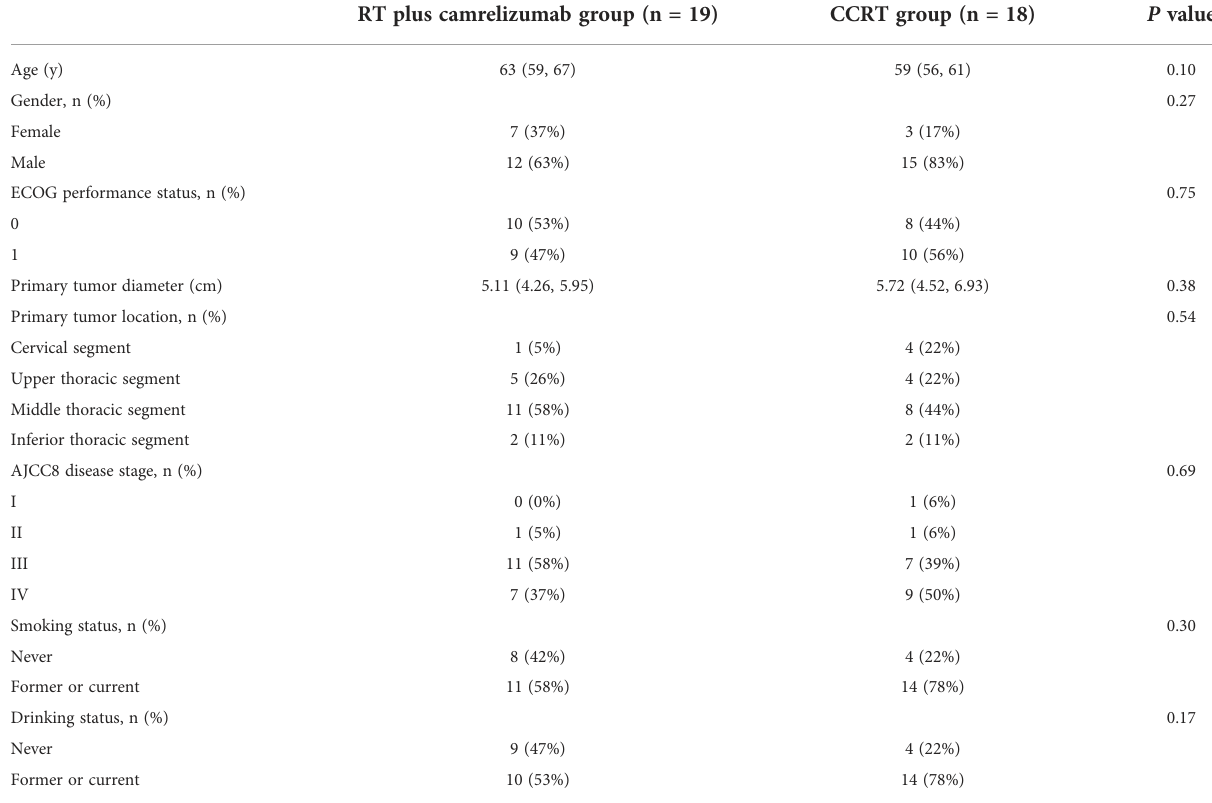
TABLE 1 Baseline characteristics of patients in two